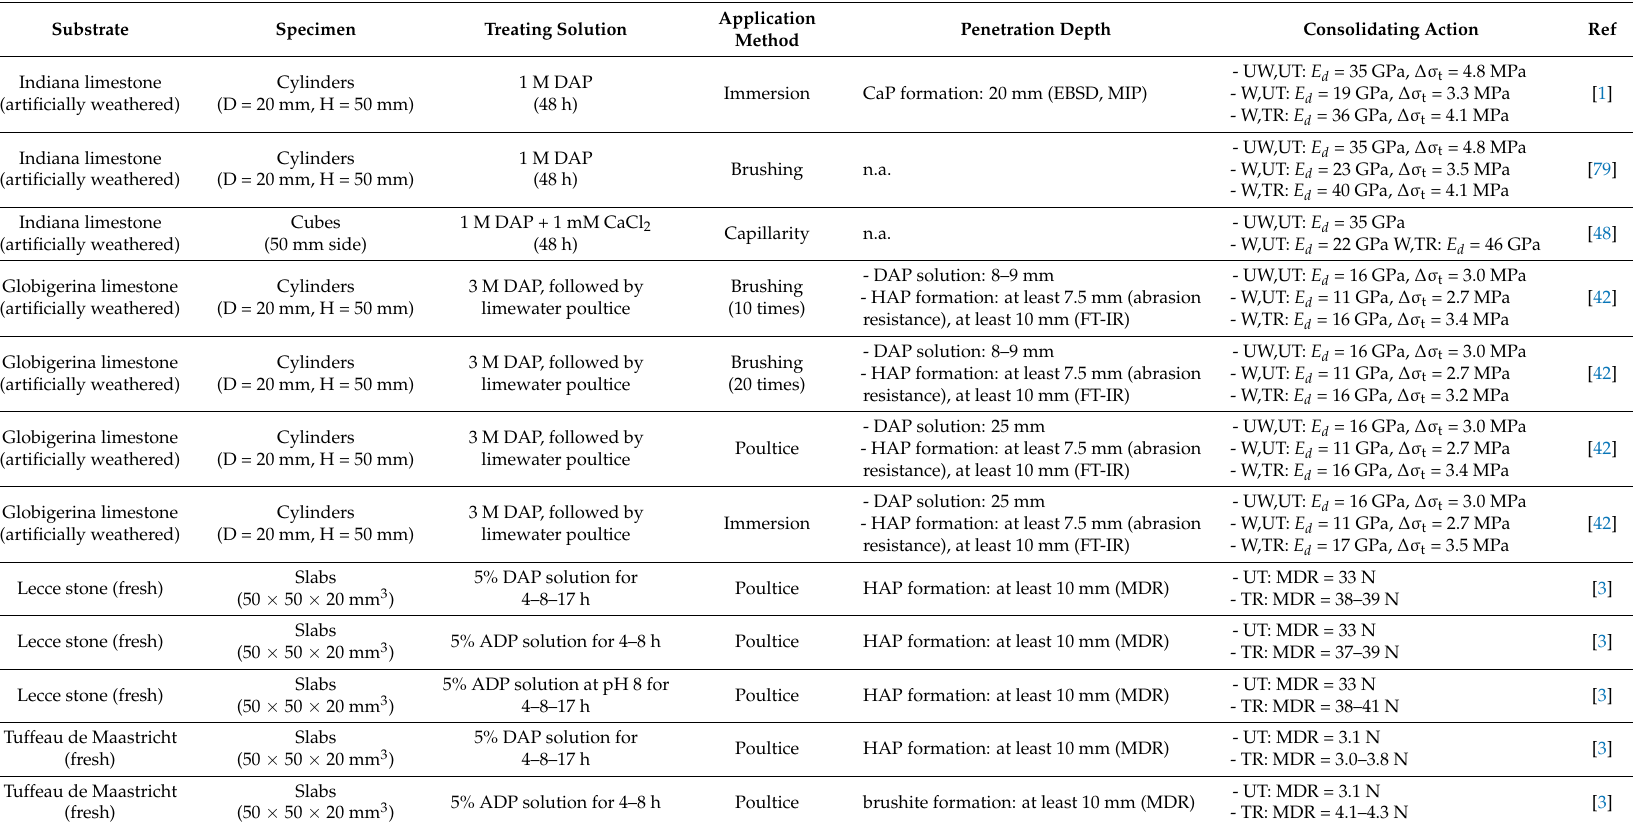
Table 6. Consolidating ability of the phosphate treatment applied to limestone (D = diameter; H = height; UW = unweathered; W = weathered; UT = untreated; TR = treated; E d = dynamic elastic modulus; σ t = tensile strength; σ c = compressive strength; MDR = micro-drilling resistance in the first 10 mm from the treated surface; HD = hardness; w, STT = weight loss after the scotch tape